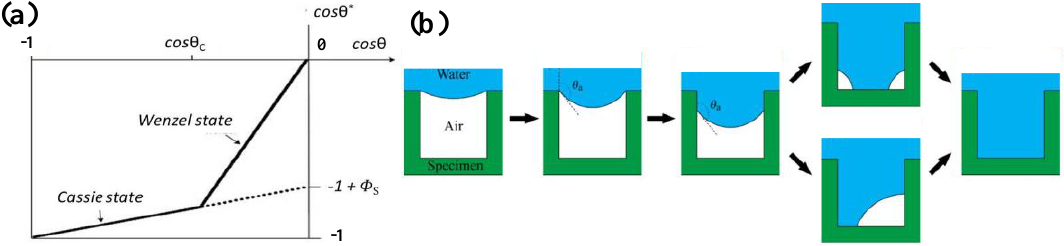
Figure 4. ( a ) The transition between the Cassie–Baxter and Wenzel state [3]; reproduced with permission from the Nature Publishing Group. ( b ) Wetting transition from the Cassie–Baxter state to the Wenzel state [108]; reproduced with permission from the American Chemical Society.